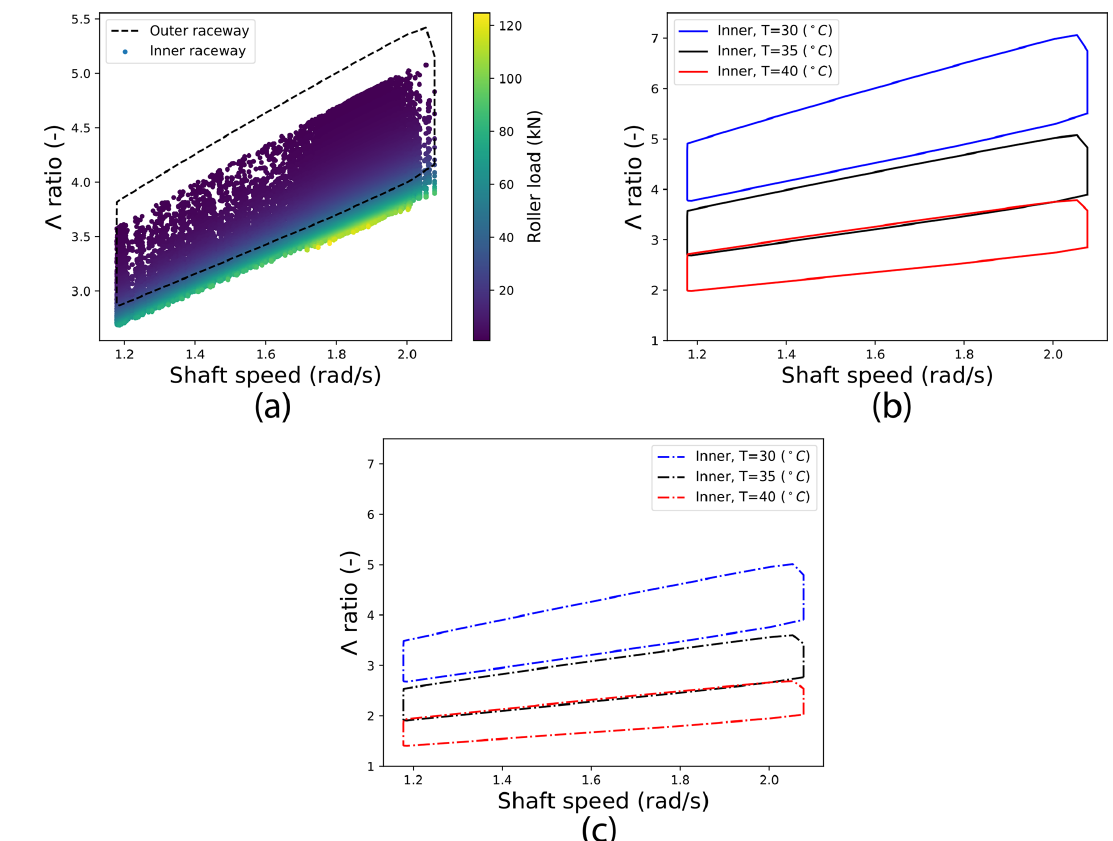
Figure 3. Steady-state dimensionless film thickness ( (cid:51) ) results. Panel (a) shows inner- and outer-raceway results at T = 35 ◦ C, (b) shows inner-raceway results when T is varied and (c) shows the same results having applied a crude order of magnitude estimate of the effect of